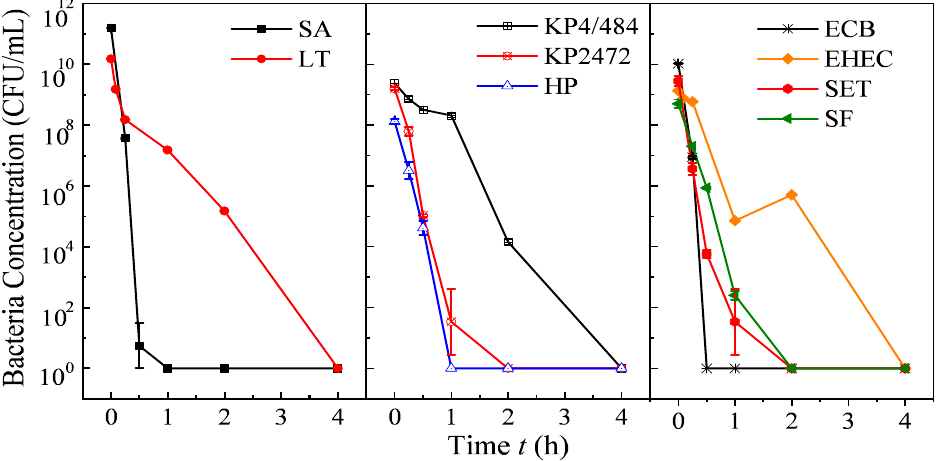
Figure 5. Antimicrobial tests of Cu x Fe y O z NPs (1 mg/mL in PBS) against various pathogenic bacteria. The acronyms for bacteria are listed in Table 2. Results represent 3 independent challenge experiments (2 for KP4/484) and are expressed as mean and standard deviation of bacterial concentration (in CFU/mL). Table 2. Antimicrobial activity of the Cu x Fe y O z NPs (bacterial cells were suspended in 1X PBS).